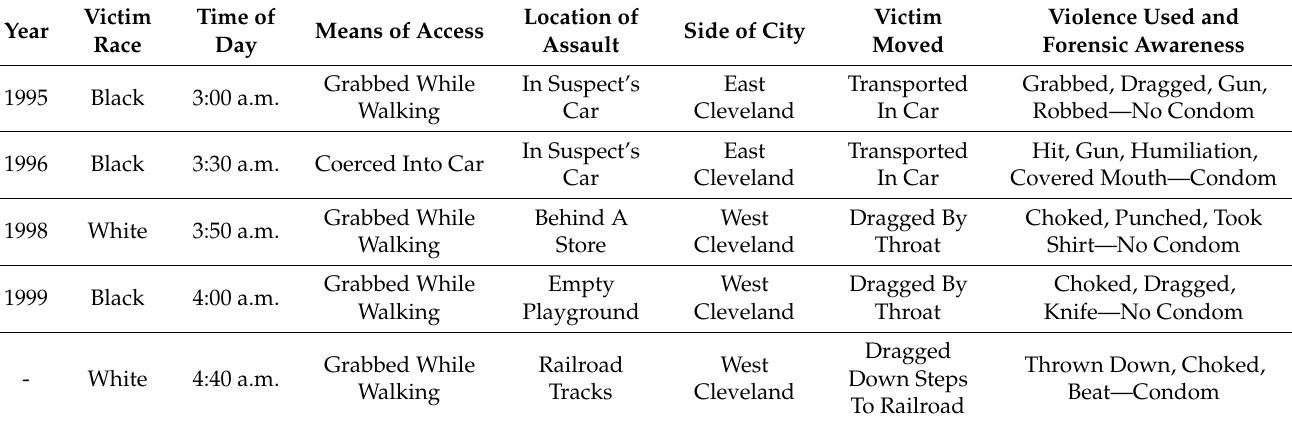
Table 2. Overview of offender’s 22 sexual